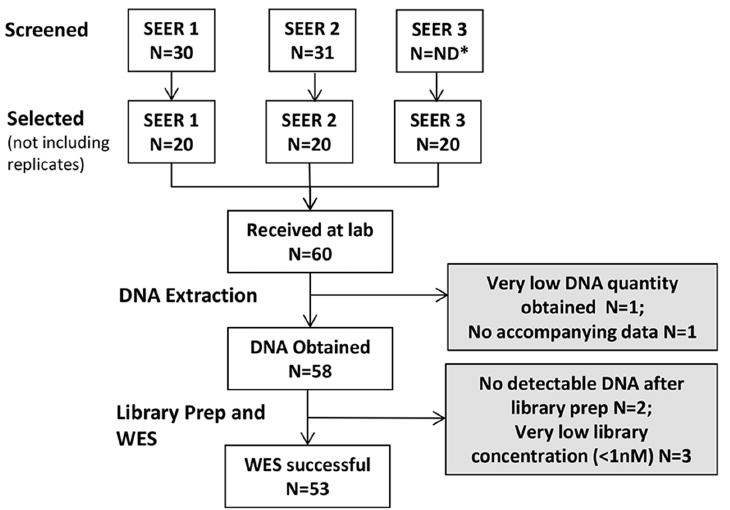
Fig 1. Workflow for the FFPE tissues. Three SEER RTRs selected cases that would likely meet the study criteria from their database. Cases were screened for histology/morphology, tumor nuclei content, and necrotic cell content to select cases meet the study criteria. The RTRs screened 30 or 31 cases; one RTR did not keep track of the number of cases they screened. Each RTR selected and sent 20 cases that met study criteria to the lab. One case was excluded from analyses due to incomplete information regarding storage time. 59 cases were considered for subsequent analyses. DNA was successfully extracted from 58 cases. WES was successful on 53 of the cases.